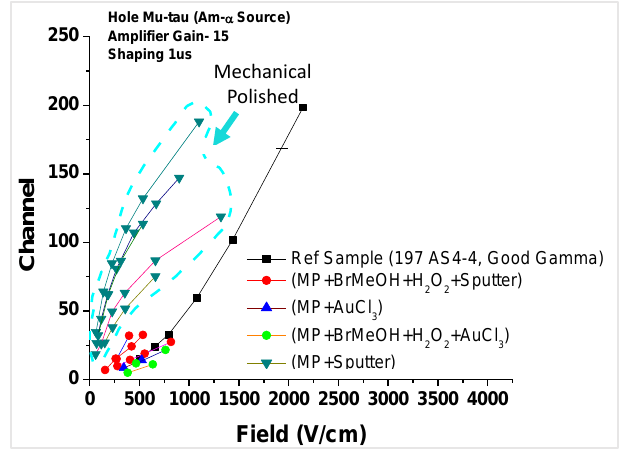
Figure 18. µτ h products determined by using 241 Am- α source for different treated surfaces in CRY-3 detectors.